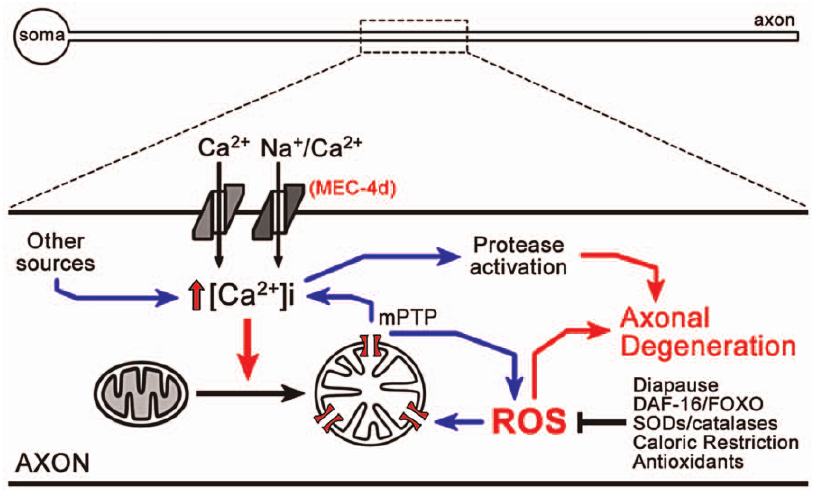
Figure 9. Model of ROS dependent neuronal degeneration. Opening of the MEC-4d channel results in an increase in intracellular calcium, which together with calcium contribution from other sources leads to mitochondrial dysfunction, ATP depletion and ROS generation, which enters into positive feedback loops, finally leading to activation of proteases in somas and axons. In dauer and daf-2 mutants, anti-ROS systems are elevated, decreasing mitochondrial dysfunction and blocking neuronal degeneration in